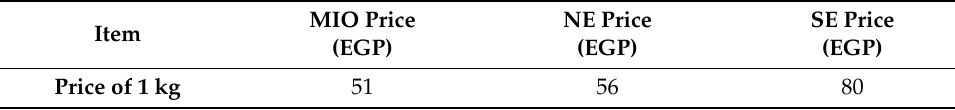
Table A2. Reference price list for different cooling